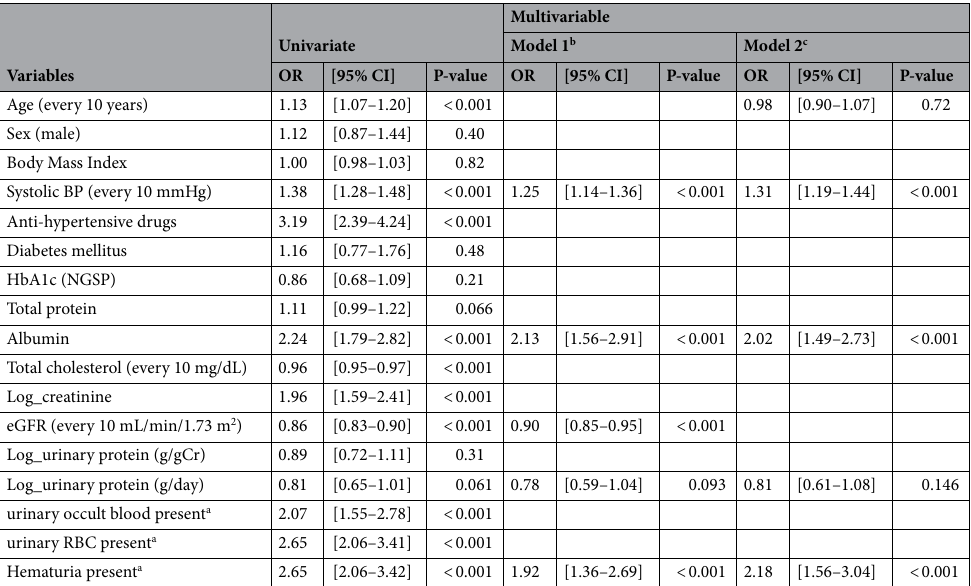
Table 3. Associating factors with FSGS vs. MCD. FSGS focal segmental glomerulosclerosis, OR odds ratio, CI confidence interval, BP blood pressure, eGFR estimated glomerular filtration rate, RBC red blood cell, HPF high powered field. a Definition: Urinary occult blood present, (1+), (2+), (3+) on dipstick; Urinary RBC present, ≥ 5/HPF in urine sediment; Hematuria present, (1+), (2+), (3+) on dipstick and ≥ 5/HPF in sediment. b Multivariable model 1: Adjusted for systolic blood pressure, albumin, eGFR, daily urinary protein (log- transformed), hematuria. c Multivariable model 2: Adjusted for age, systolic blood pressure, albumin, daily urinary protein (log-transformed),